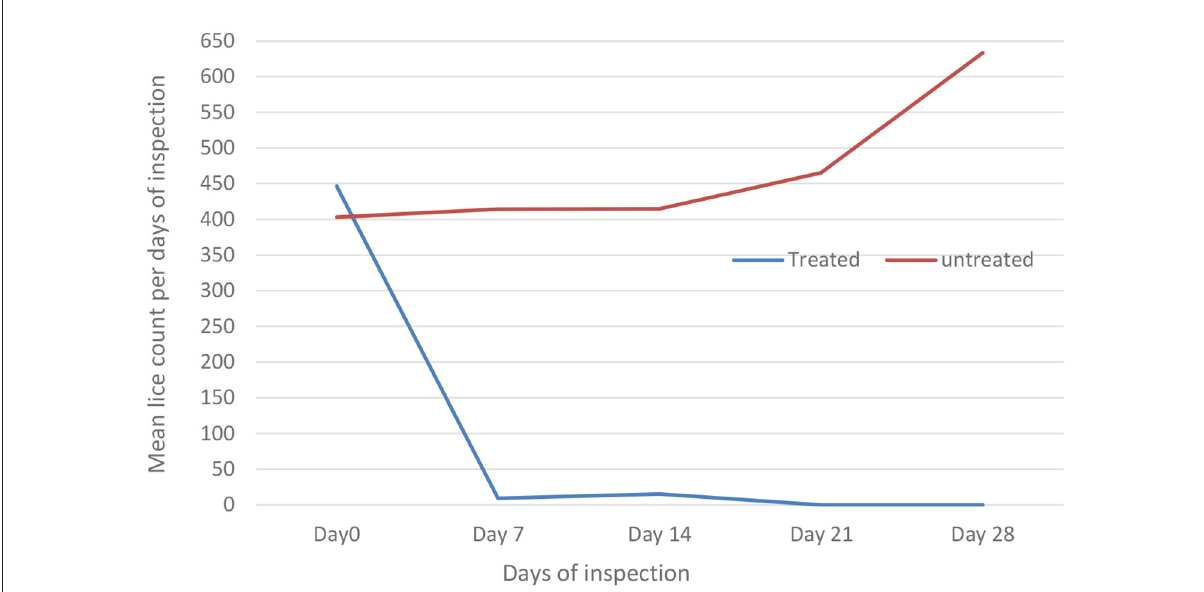
FIGURE2 Effect of diazinon treatment on sheep lice infestation (mean lice count) among treated and untreated groups per days of inspection in Sayint district.